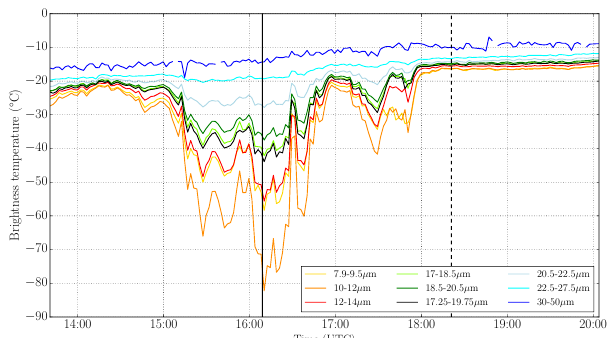
Figure 12. Radiances measured with the FIRR and simulated with MODTRAN for the 21 February 2015 night experiment. Blue error bars correspond to simulations with temperature profiles offset by ± 1K. Red error bars correspond to simulations with specific hu- midity profiles offset by ± 10%.